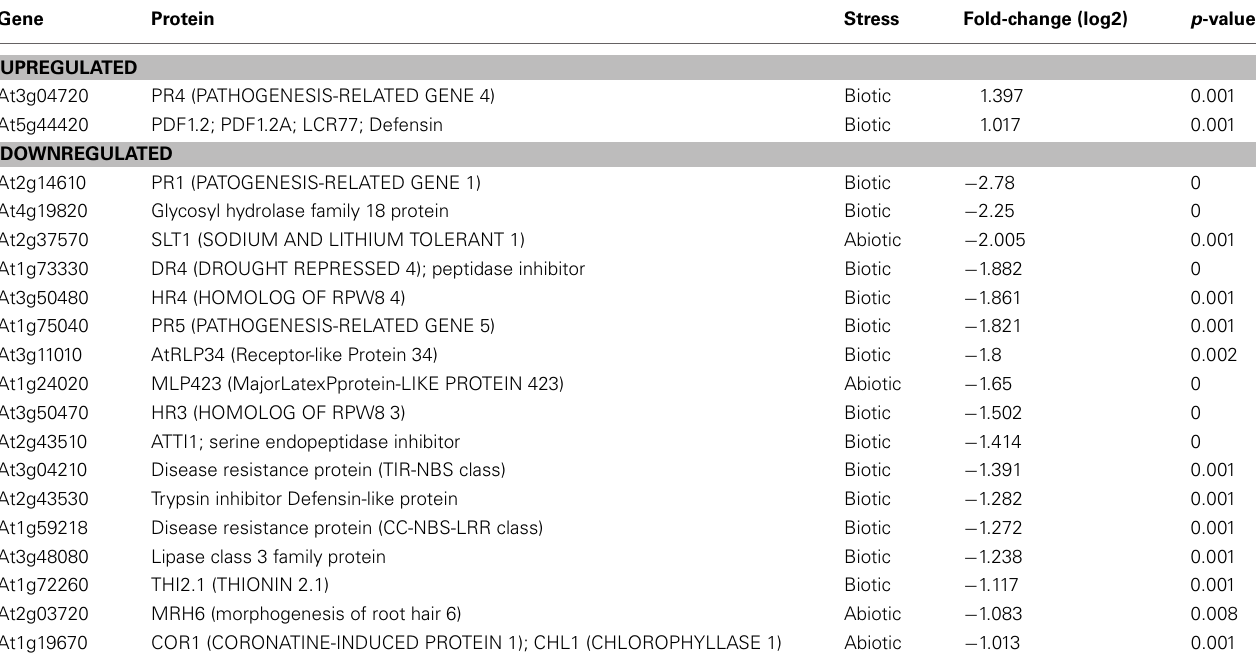
Table 1 | Changes in “Stress Responsive” Transcripts in hot5-2 vs. wild-type.